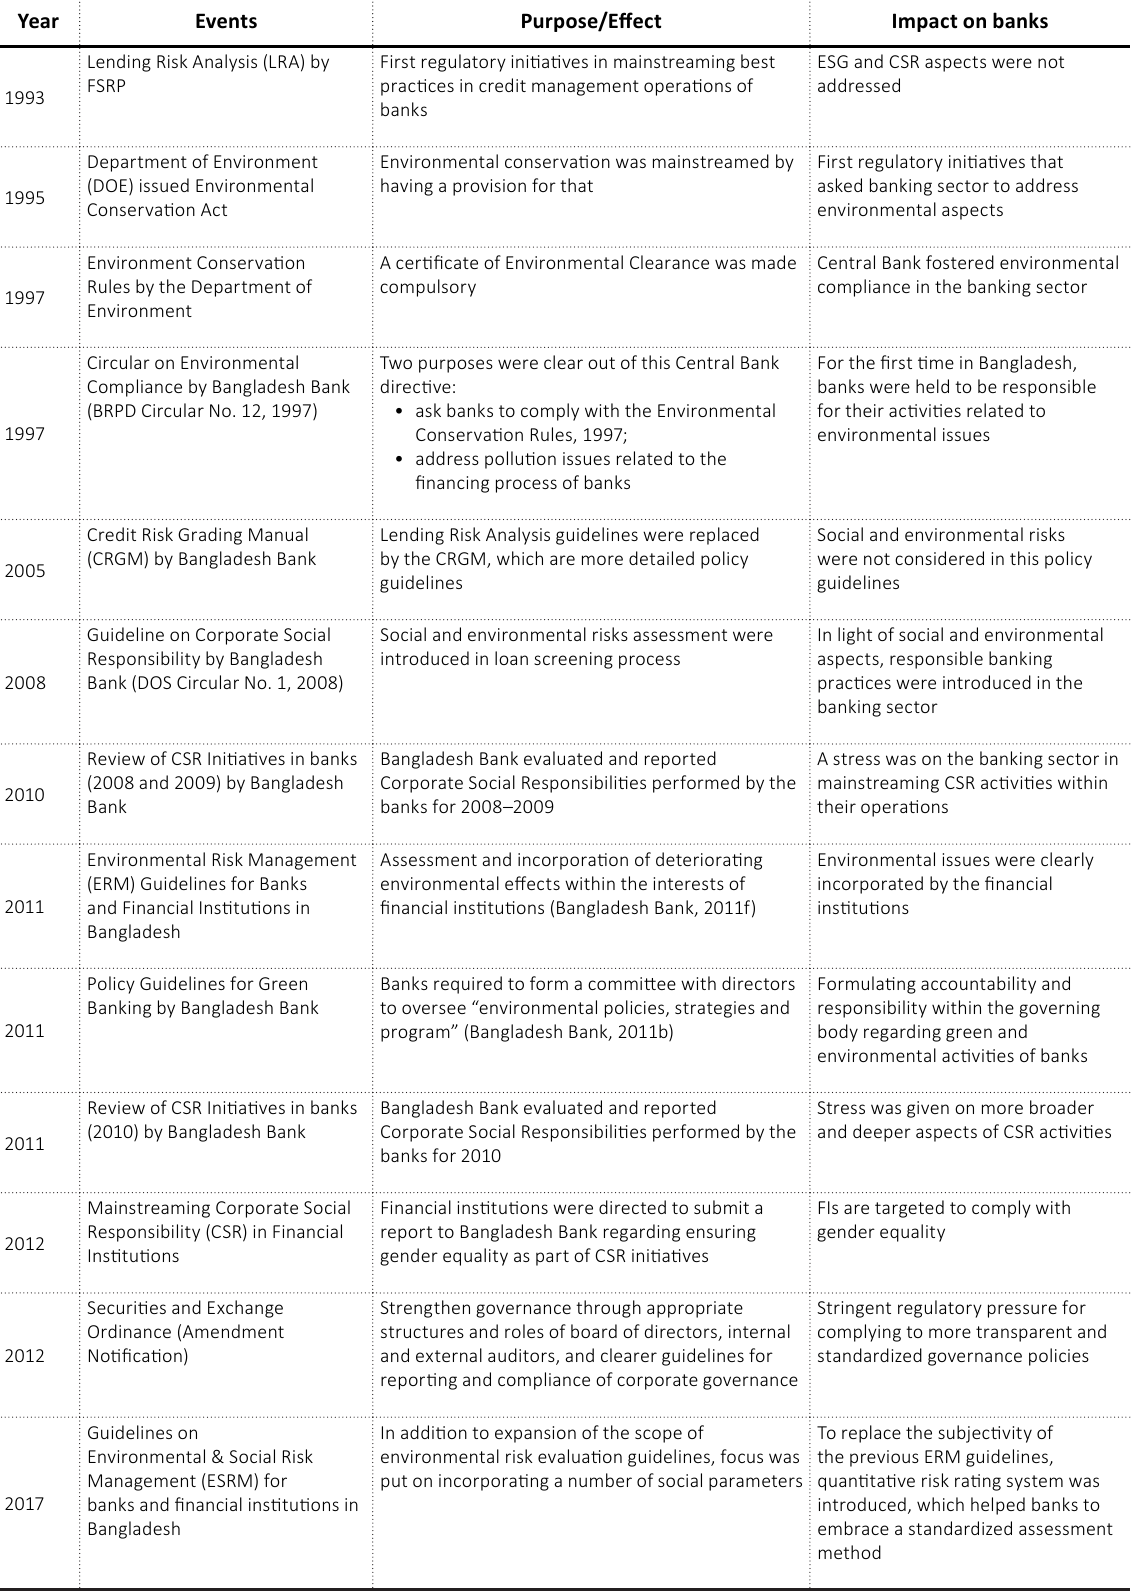
Table 1. History of development of CSR guidelines/regulations in